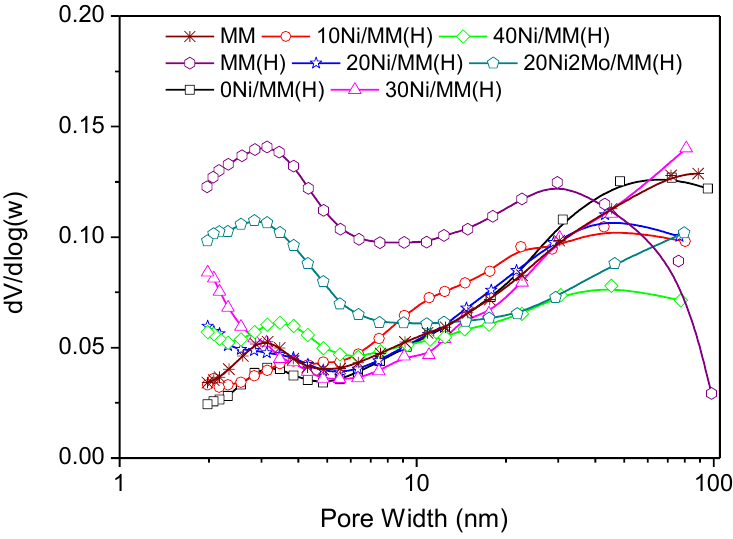
Figure 3. Pore volume distribution of the supports and the catalysts.